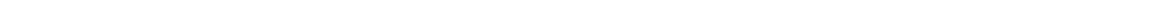
Fig. 5 FBXO32 is required for neuronal EMT during brain development. a Schematic representation of cellular morphology changes in a developing mouse cortex (E14.5) across its various layers viz. ventricular zone (VZ), sub ‐ ventricular zone (SVZ), intermediate zone (IZ) and cortical plate (CP). b Normalized tag counts for key EMT markers in RNA-seq data derived from the ventricular zone (VZ), the sub-ventricular zone (SVZ), and the cortical plate (CP) of E14.5 mouse cortex. c The levels of Fbxo32 mRNA are shown as the average normalized tag counts derived from the RNA-seq data used in (b). d RT-PCR analysis of Fbxo32 in FAC-sorted cells from E14.5 mouse cortex using antibodies against CD133 and NCAM surface markers. The mRNA levels were measured relative to Ctcf via RT-PCR, and the results were plotted on the y-axis. Error bars represent the SEM of independent biological replicates ( n = 3). e The expression pattern of Fbxo32 mRNA as visualized by in situ hybridization in E14.5 cortex. The data were extracted from the publically available data set “ gene paint. ” f Graphical representation of in utero electroporation (IUE). g In utero electroporation was performed at E12.5 using plasmids containing GFP and with control shRNA or shRNA against Fbxo32, and the mice were euthanized at E16.5 for further analyses. A representative image ( n = 3) of the immuno fl uorescence analysis performed with anti-GFP and anti-SATB2 antibodies showing the retention of GFP-positive cells below the SATB2 layer in a brain electroporated with Fbxo32 shRNA compared to a control brain. h A bar plot showing quanti fi cation of the migrated GFP-positive cells in control and Fbxo32-depleted mouse brains with respect to SATB2 staining. The y-axis represents the percentage of cells on or below the Satb2-stained region. The error bars represent the SEM of three independent biological replicates. * p < 0.05, Student ’ s t test. i The cortex was divided into fi ve equal bins as shown in g , and the number of electroporated cells was counted in each bin. The percentage of cells in each bin was plotted on the y-axis. Error bars re fl ect the S.E. M. of quanti fi cations from independent brains, and signi fi cance was calculated using a t-test comparing shControl and shFbxo32 electroporated brains (* < 0.05) ( n = 3). j The expression of FBXO32 during human neurogenesis in vitro is depicted using normalized tag counts from RNA-seq data for various stages of this process in a previous study 46 . See also Supplementary Fig.